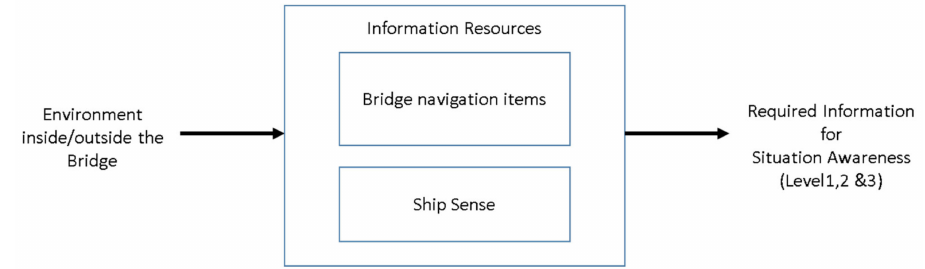
Figure 1. Flow from environment inside / outside bridge to required